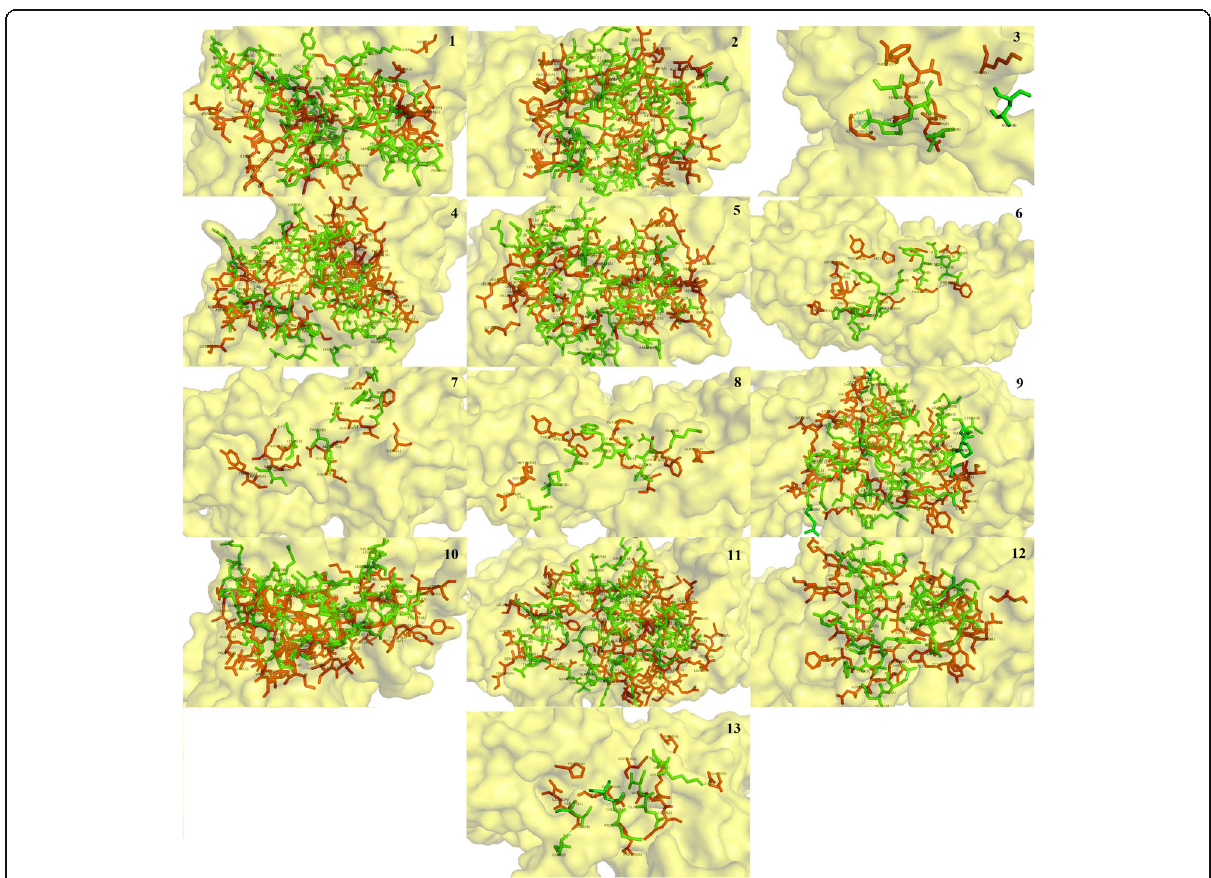
Fig. 6 Three-dimensional binding representation of NMDAR (rats) with each conantokin ligand: ( 1 ) conantokin Br, ( 2 ) conantokin E, ( 3 ) conantokin G, ( 4 ) conantokin L, ( 5 ) conantokin P, ( 6 ) conantokin Pr1, ( 7 ) conantokin Pr2, ( 8 ) conantokin Pr3, ( 9 ) conantokin R, ( 10 ) conantokin R1B, ( 11 ) conantokin R1C, ( 12 ) conantokin R1A, ( 13 ) conantokin T. Receptor chain (red), ligand chain (green), ligand-receptor complex surface